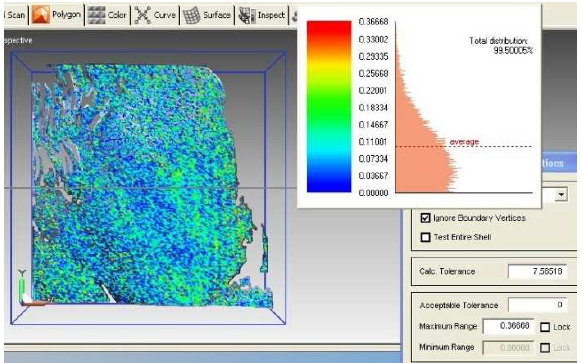
Figure 9. The deviations points-model (from the C10 scans) for the chest of the horse